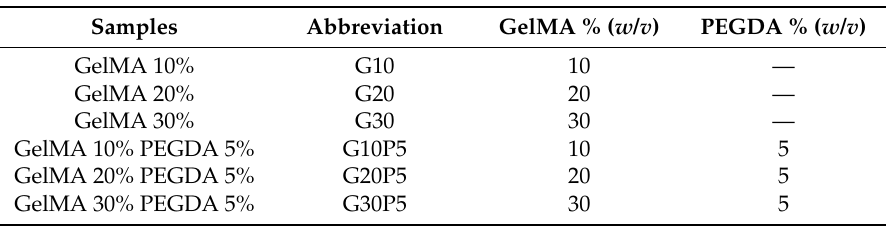
Table 1. Composition of